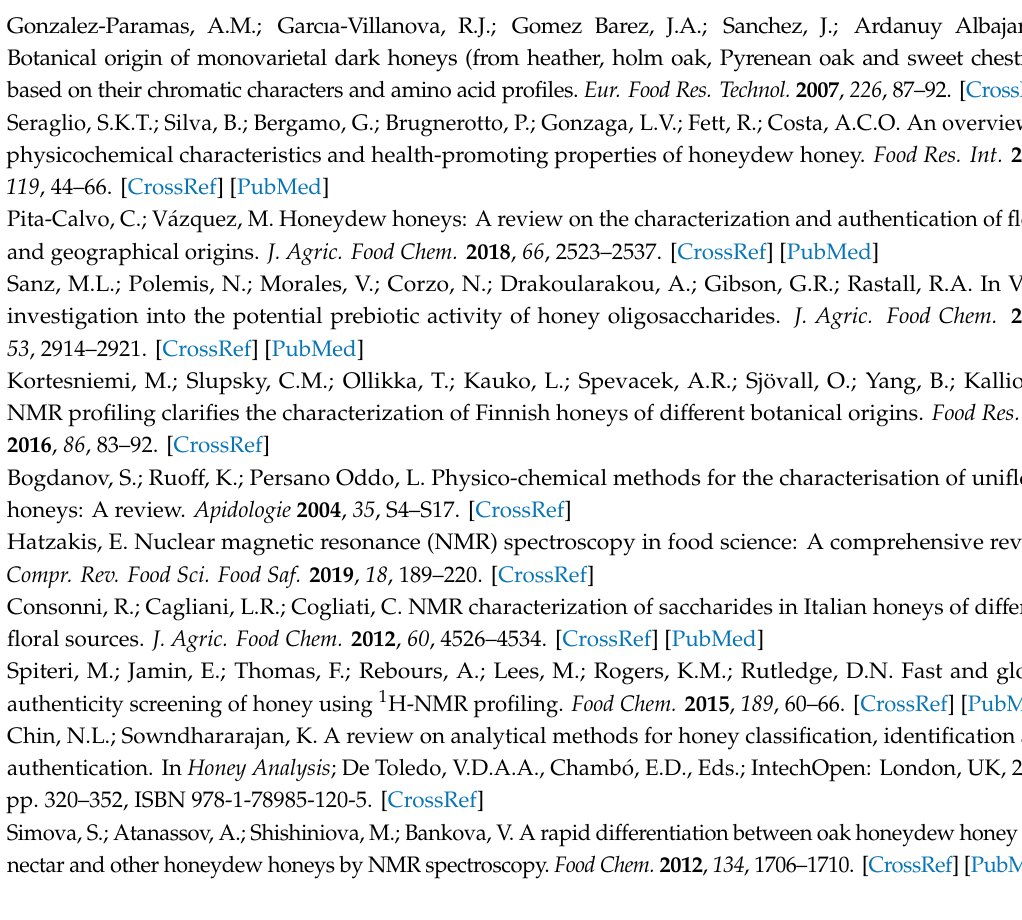
Table S1: Honey samples used for NMR analysis, Table S2: Concentration range (min-max) and average content (avg) of studied components according to origin of honey, Figure S1: Permutation test for Bulgarian mixed honey class in PLS-DA model, Figure S2: Permutation test for North Macedonian mixed honey class in PLS-DA model, Figure S3: Permutation test for Bulgarian honeydew honey class in PLS-DA model, Figure S4: Permutation test for North Macedonian honeydew honey class in PLS-DA model, Figure S5: Permutation test for Bulgarian polyfloral honey class in PLS-DA model, Figure S6: ROC analysis for Bulgarian mixed, North Macedonian mixed, Bulgarian honeydew, North Macedonian honeydew and Bulgarian polyfloral honeys, Figure S7: Full 1 H-NMR spectrum of sample M13 and assignment of the identified signals in the regions 1.10–2.40 ppm and 4.90–5.45 ppm, Figure S8: Full 13 C-NMR spectrum of sample M13 and assignment of the signals, used in the chemometric analysis shown in Table